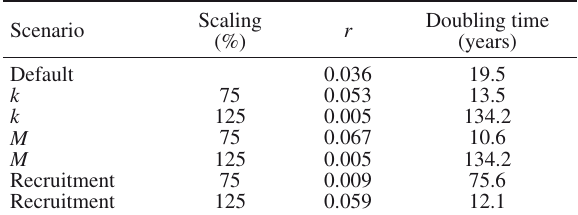
Table 3. – Summary of sensitivity analysis; k is the growth coef- ficient from the von Bertalanffy growth equation, M is the assumed level of natural mortality and recruitment is a function of births and first-year mortality ( M ). 0